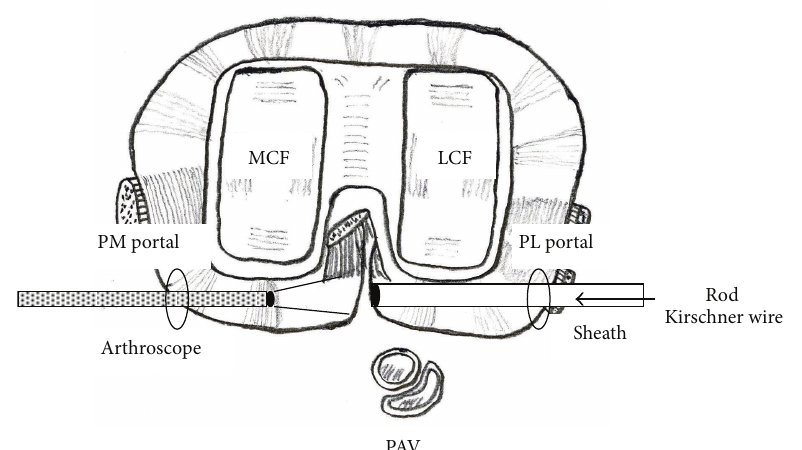
Figure 5: This schema demonstrates the method to create a posterior transseptal portal. A sheath inserted from the posterolateral portal is pushed to the septum to protect popliteal vessels that lie immediately behind the lateral posterior capsule. Viewing the septum through the posteromedial portal, it is perforated first by using a 1.5 mm Kirschner wire followed by a 3.0 mm Kirschner wire through the sheath from the posterolateral portal (arrow). PM portal, posteromedial portal; PL portal, posterolateral portal; PAV, popliteal artery and vein; MCF, medial condyle of the femoral component; LCF, lateral condyle of the femoral component.